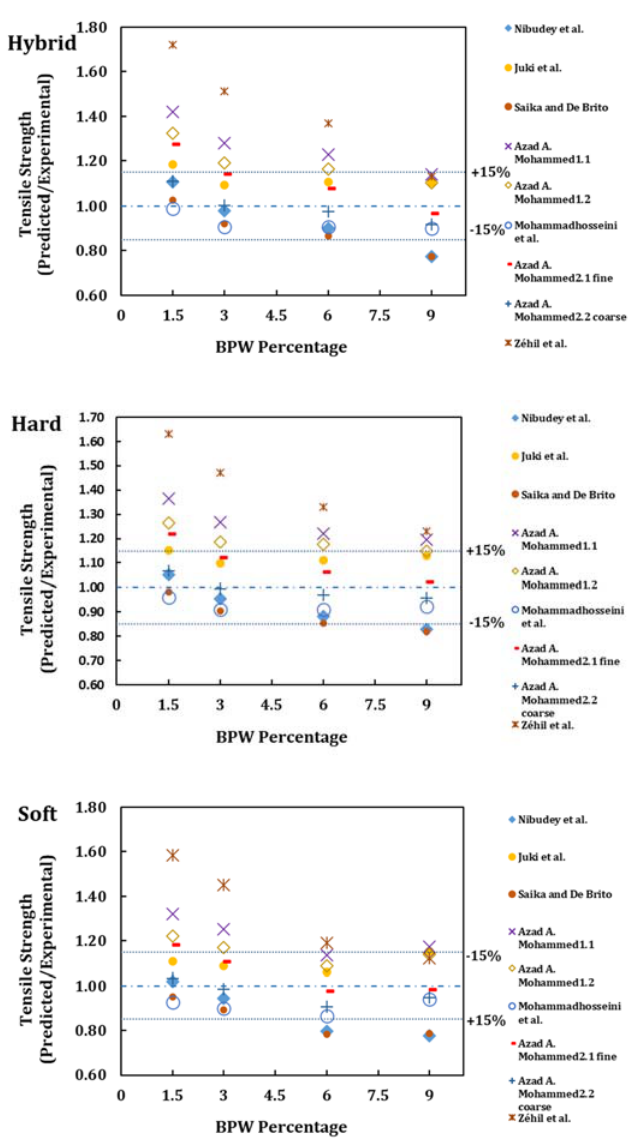
Figure 13. The ratio of predicted tensile strength from other studies for normal strength BPW- containing concrete, and experimental results [39,50–55].